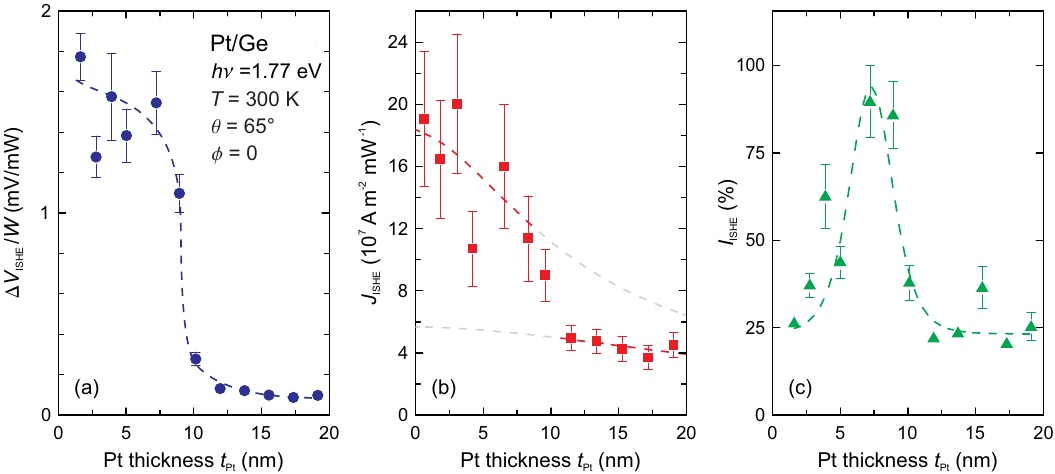
Figure 5. ( a ) ISHE signal measured at h ν = 1.77 eV in a Pt/Ge sample kept at room temperature as a function of the Pt thickness t Pt (dashed line: guide for the eye). Geometrical parameters: θ = 65 ◦ and φ = 0. The values are normalized to the power W entering into the Ge substrate; ( b ) Inverse spin-Hall current density J ISHE = σ c ∆ V ISHE / ( d · W Ge ) (squares), normalized to the transmitted power W as a function of the Pt thickness. The lower dashed line represents the fitting function for t Pt > 10 nm calculated using Equation (5) with the free parameters L s = 8.2 ± 3.5 nm and γ J s 0 = ( 1.1 ± 0.2 ) × 10 8 A · m − 2 · mW − 1 . The upper dashed line corresponds to the fitting function of Equation (5) for t Pt < 10 nm with the free parameters L s = 3.5 ± 2.1 nm and J s 0 = ( 3.7 ± 0.6 ) × 10 8 A · m − 2 · mW − 1 ; ( c ) Normalized I ISHE = ∆ V ISHE / R dependence as a function of the Pt thickness: the maximum value is obtained for t Pt ≈ 10 nm, in agreement with the ISHE measurements of Ref.